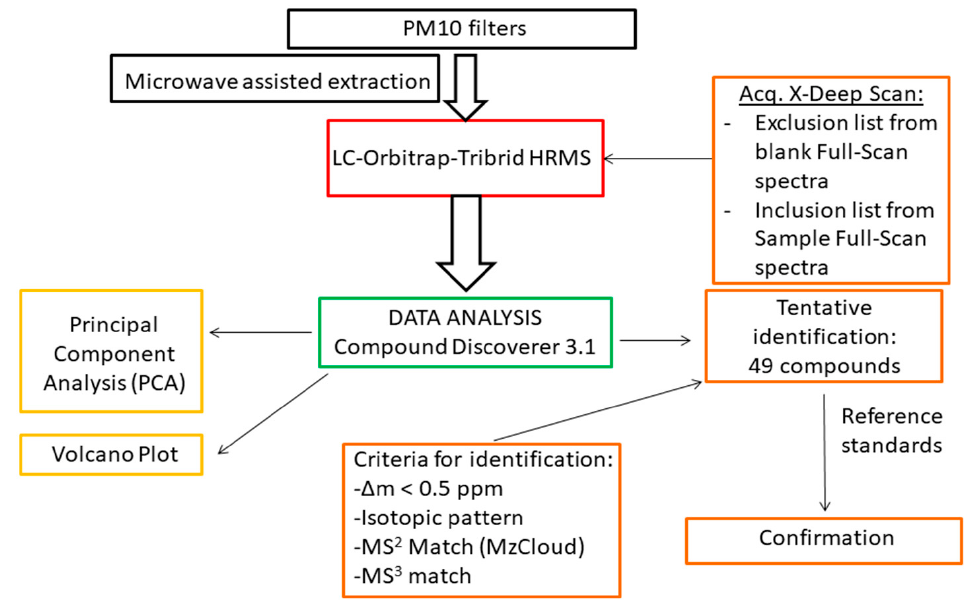
Figure 1. Workflow of the different steps of the study.